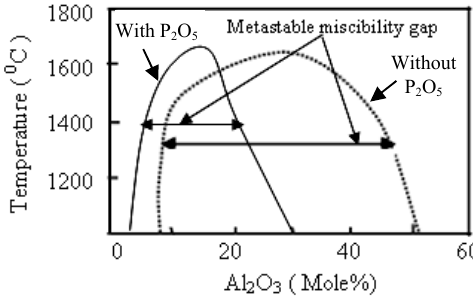
Figure 1. Metastable immiscibility zone of SiO 2 –Al 2 O 3 system with and without P 2 O 5 .